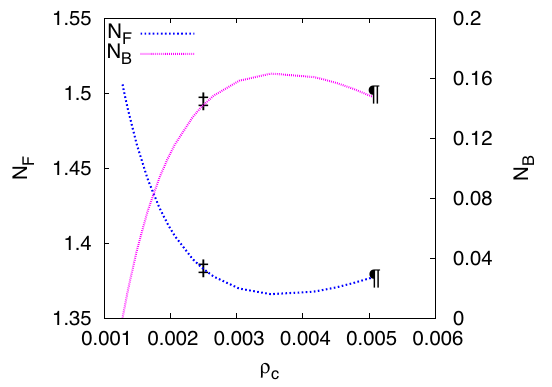
Fig. 9 Initial data of a mixed fermion-boson star with fi xed total mass M T ¼ 1 : 4. The numbers of fermions, N F , and bosons, N (denoted N B in the fi gure, but just N in this text), in terms of the central density, q c , are plotted. The position of the maximum of N (and correspondingly the minimum of N F ) represents the critical point, with a maximum value N = N F ¼ 12 % , which separates the stable and the unstable solutions. The two con fi gurations marked, one on each side of the maximum/minimum, correspond to N = N F (cid:5) 10 % . Reproduced with permission from Valdez-Alvarado et al. (2013), copyright by